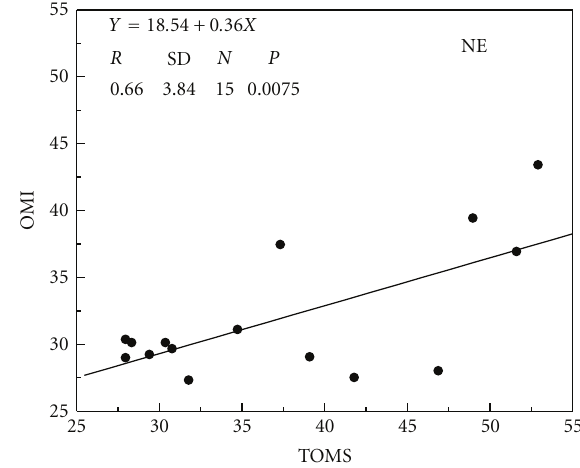
Figure 7: NCEP/NCAR reanalysis vertical wind at 100 hpa over NE from 1979–2009.